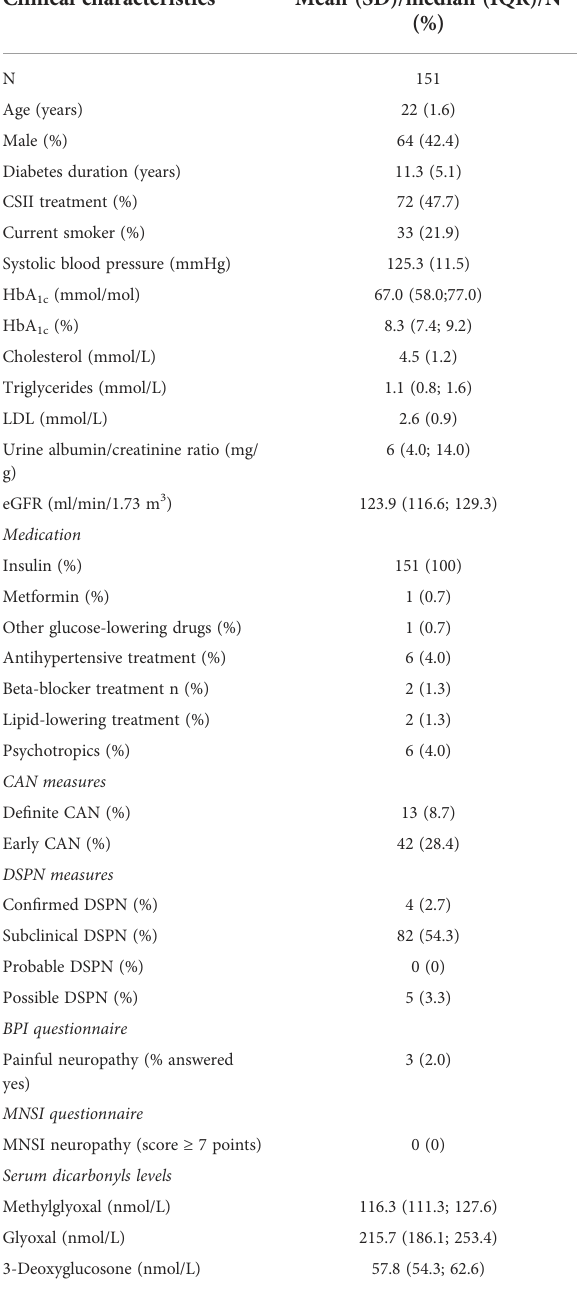
TABLE 1 Characteristics of the study population. Clinical